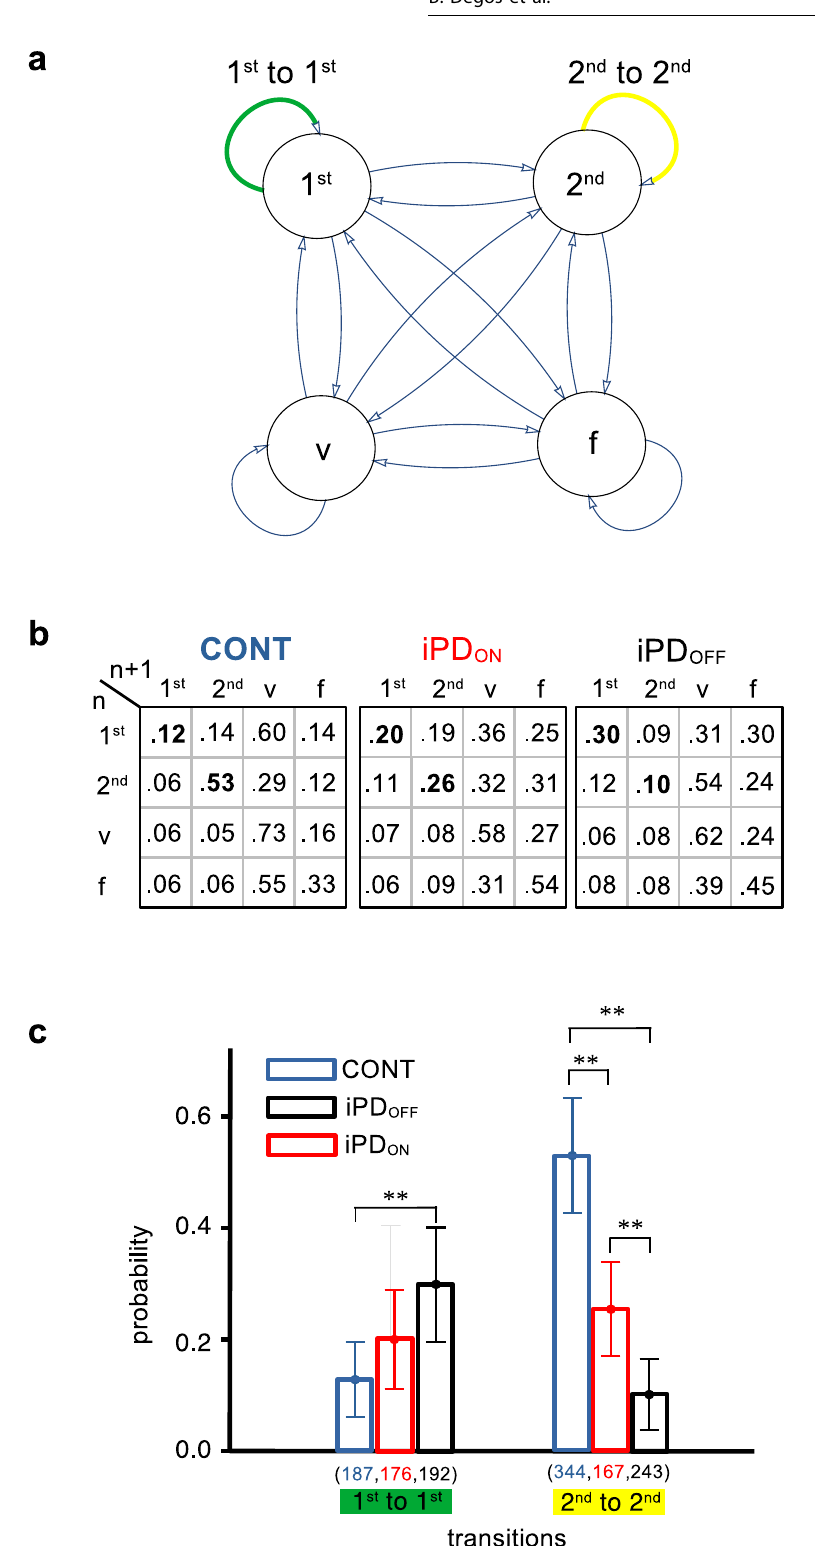
Fig. 9 4-state Markov process. a Schematic representation of the 4-state Markov process hypothetically underlying sequences of trials in the explicit condition. Each node represents a given state ( ‘ 1 st ’ : fi rst mode; ‘ 2 nd ’ : second mode; ‘ v ’ : visually-guided saccade; ‘ f ’ : failed trial). Arrows represent transitions between states in trial ‘ n ’ and ‘ n + 1 ’ . The green arrow represents a sequence of two 1 st mode responses. The yellow arrow represents a sequence of two 2 nd mode responses. b Transition matrices for the different groups (iPD or control) and treatments (ON or OFF L-DOPA). Same color code as in a . c Transition probabilities for 1 st to 1 st and 2 nd to 2 nd transitions in the different groups of subjects. Stars indicate signi fi cant differences at p < 0.003 using the method of Schenker & Gentleman with Bonferroni correction for multiple comparisons ( n =